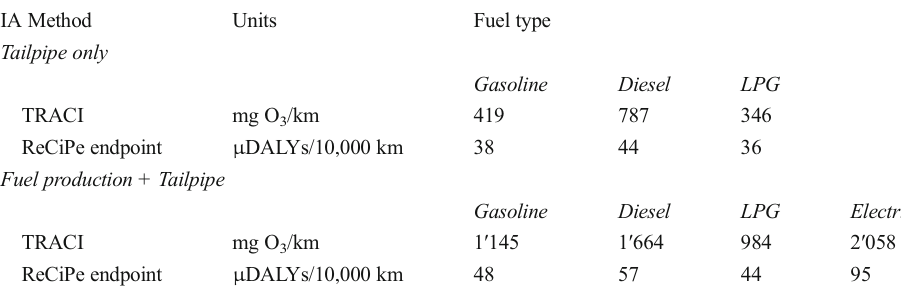
gasoline, diesel, LPG and battery electric – Ford